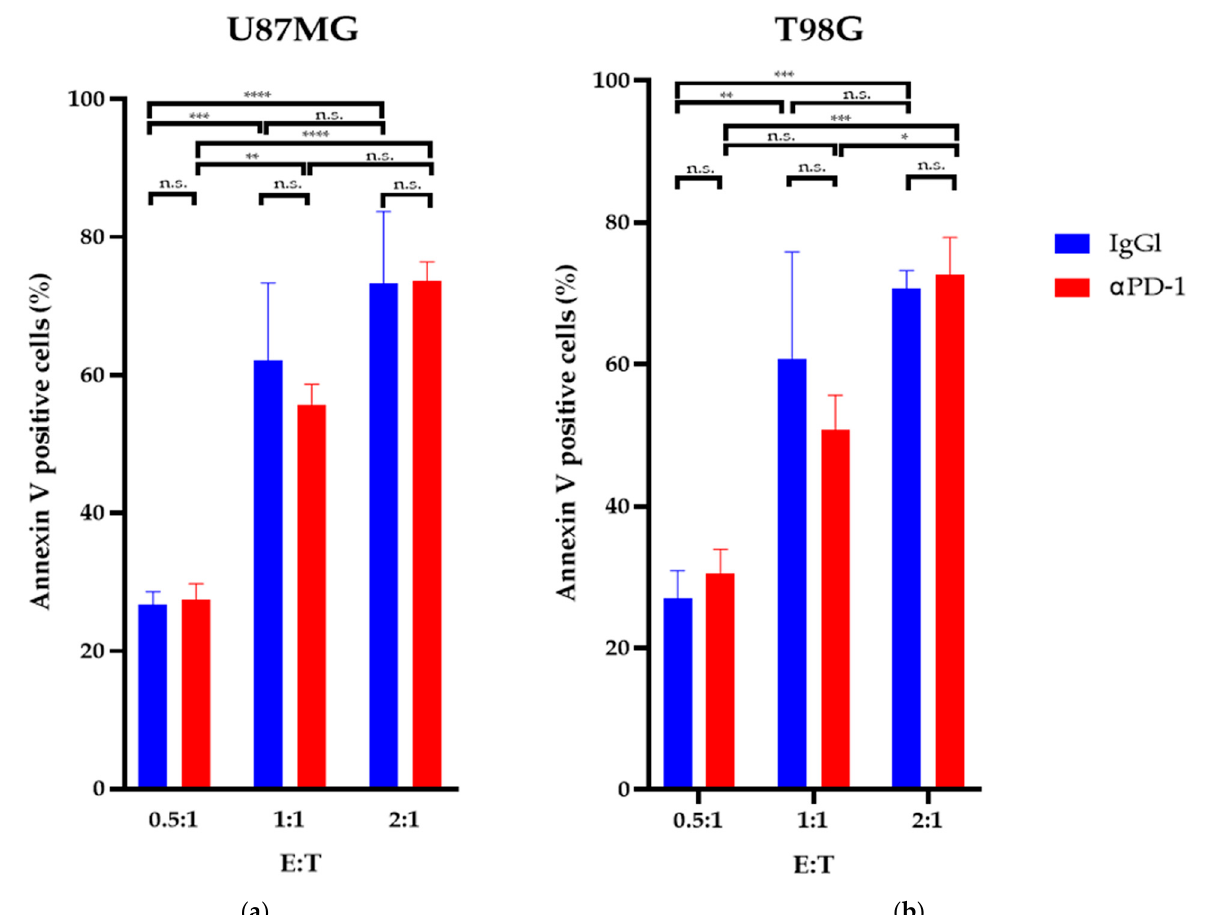
Figure 3. Apoptosis-inducing effects of GiNK on GBM cell lines in vitro. U87MG ( a ) and T98G ( b ) cell lines were exposed to GiNK at a GiNK:GBM cell ratio of 0.5:1, 1:1, and 2:1 with and without a PD-1 blocker (nivolumab). Nonadherent and detached adherent cells were stained with Annexin V–FITC, and the stained cells were analyzed using flow cytometry. Annexin V-positive cells are presented as a percentage of apoptotic cells from the total number of counted cells. The graphs show the percentages of Annexin V-positive apoptotic U87MG and T98G cells. Data are presented as the mean ± SE of at least two independent experiments ( n = 3). P values were determined using a two-way ANOVA followed by a Sidak’s test. **** p < 0.0001; *** p < 0.001; ** p < 0.01; * p < 0.05; n.s.: not significant.